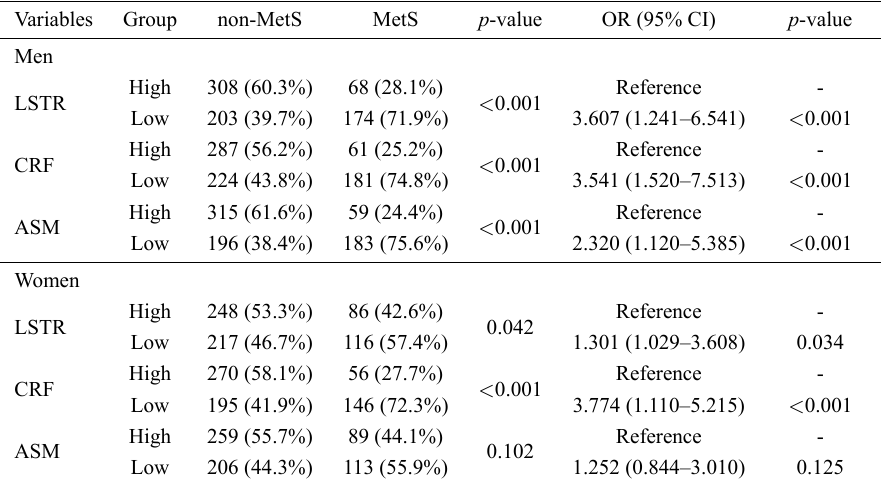
Table 4. The odds ratios for MetS according to relative values of variables.